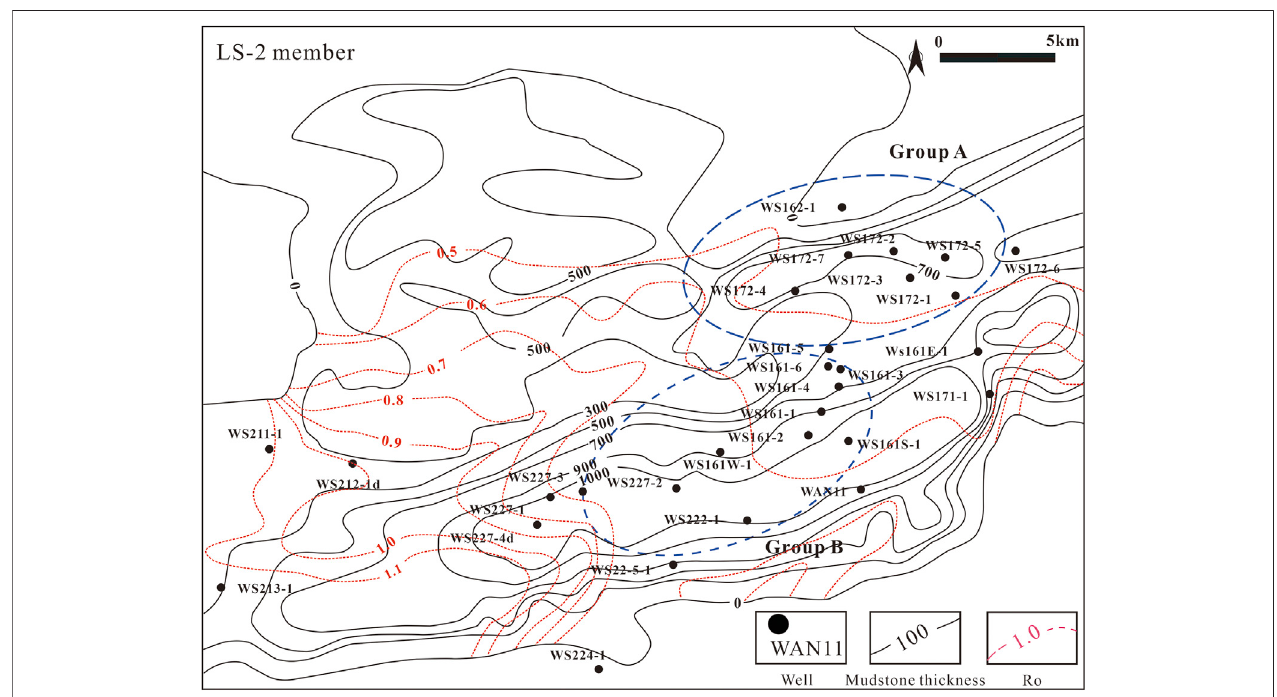
FIGURE 10 | The distribution of mudstone thickness and maturity of the second of the Liushagang Formation (LS-2 member) in the Wushi Sag (modi fi ed after (Liu et al., 2018)).